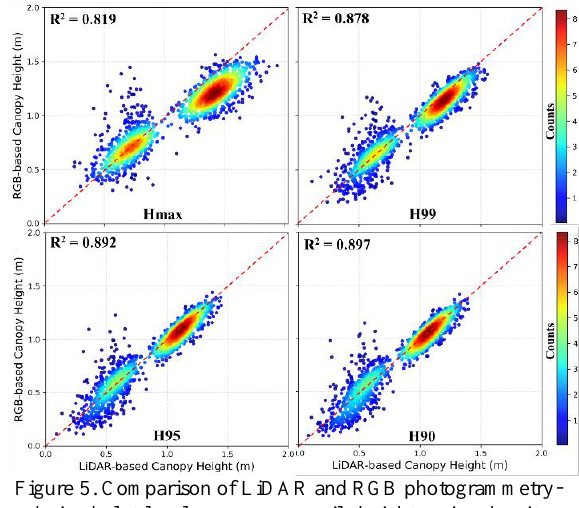
Figure 5. Comparison of LiDAR and RGB photogrammetry- derived plot-level canopy percentile heights using density scatter plots. The red dash line is the bisector (1:1 line).